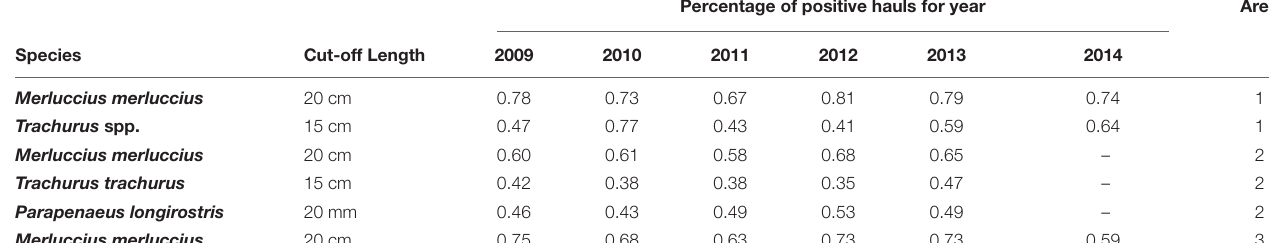
TABLE 1 | Investigated species in each study area with the relative minimum conservation reference size (MCRS) value and the proportion of annually positive hauls (Area 1 – Catalan Sea, Area 2 – Strait of Sicily, Area 3 – Ligurian and northern Tyrrhenian Seas, and Area 4 – Continental Portuguese area). Percentage of positive hauls for year